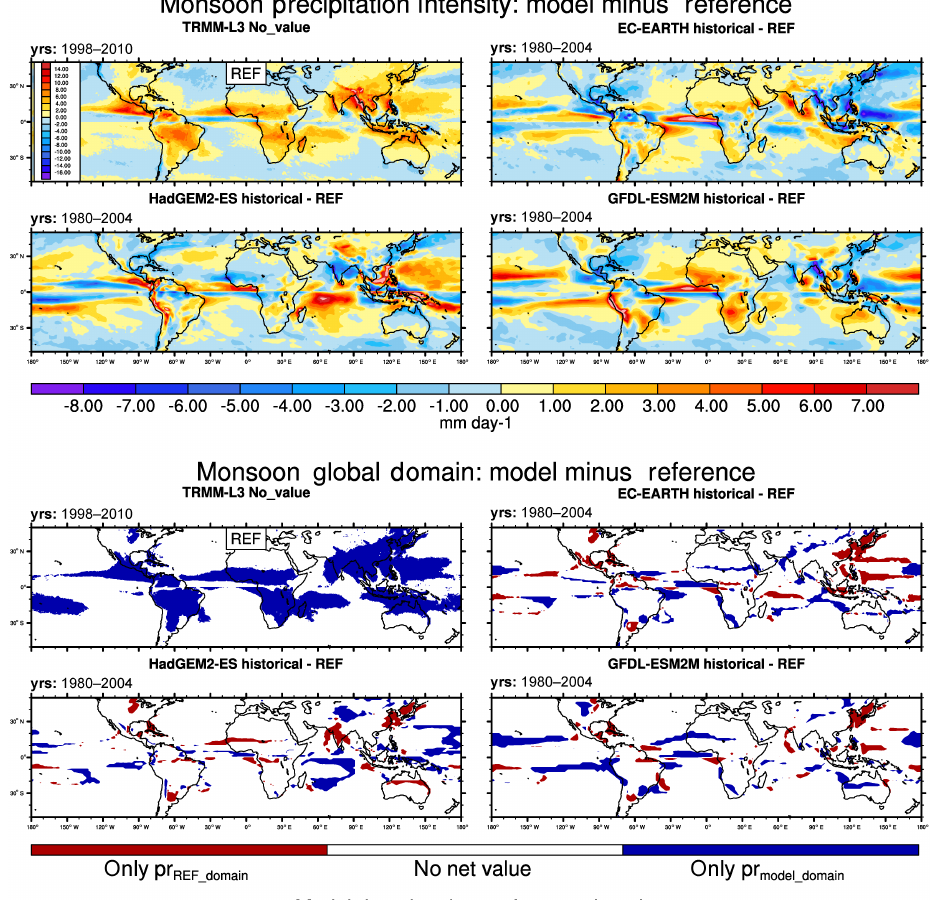
Figure 5. Monsoon precipitation intensity (upper panels) and monsoon precipitation domain (lower panels) for TRMM and an example of deviations from observations from three CMIP5 models (EC-Earth, HadGEM2-ES, and GFDL-ESM2M). The models have difficulties representing the eastward extent of the monsoon domain over the South China Sea and western Pacific, and several models (e.g. HadGEM2- ES) underestimate the latitudinal extent of most of the monsoon regions. The monsoon precipitation intensity tends to be underestimated in the South Asian, East Asian and Australian monsoon regions, while in the African and American monsoon regions the sign of the intensity bias varies between models. Similar to Fig. 9.32 of Flato et al. (2013) and produced with namelist_SAMonsoon.xml